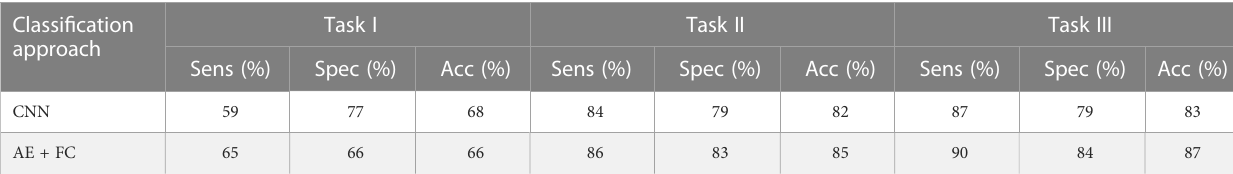
TABLE 2 Sensitivity (Sens), speci fi city (Spec) and balanced accuracy (ACC) for both CNN and AE + FC classi fi cation approaches for speci fi c classi fi cation tasks. Task I includes full data, Task II includes classi fi cation of tumor in fi ltration in white matter and Task III includes classi fi cation of highest tumor in fi ltration grade in white